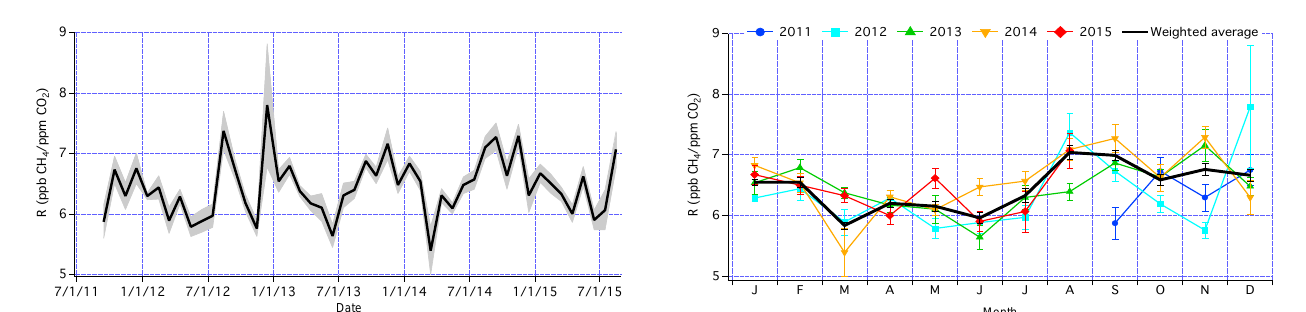
Figure 2. Time series of the Los Angeles Basin weighted-average monthly regression slopes of X CH 4 (XS) – XC O 2 (XS) (in unit of ppbppm − 1 ) and their uncertainties observed by the CLARS-FTS in the basin from September 2011 to May 2015. Uncertainties are ± 1 σ of the regression slopes.